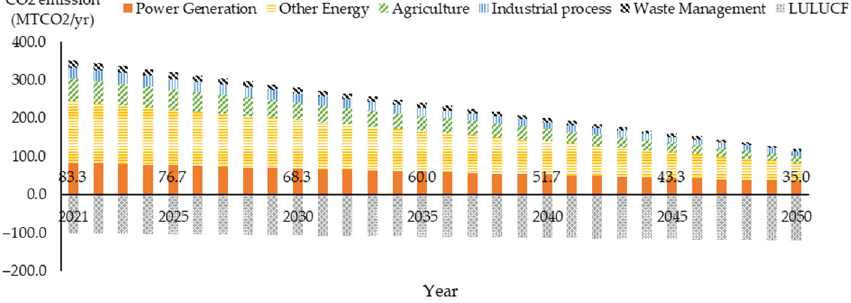
Figure 10. Average carbon dioxide emission